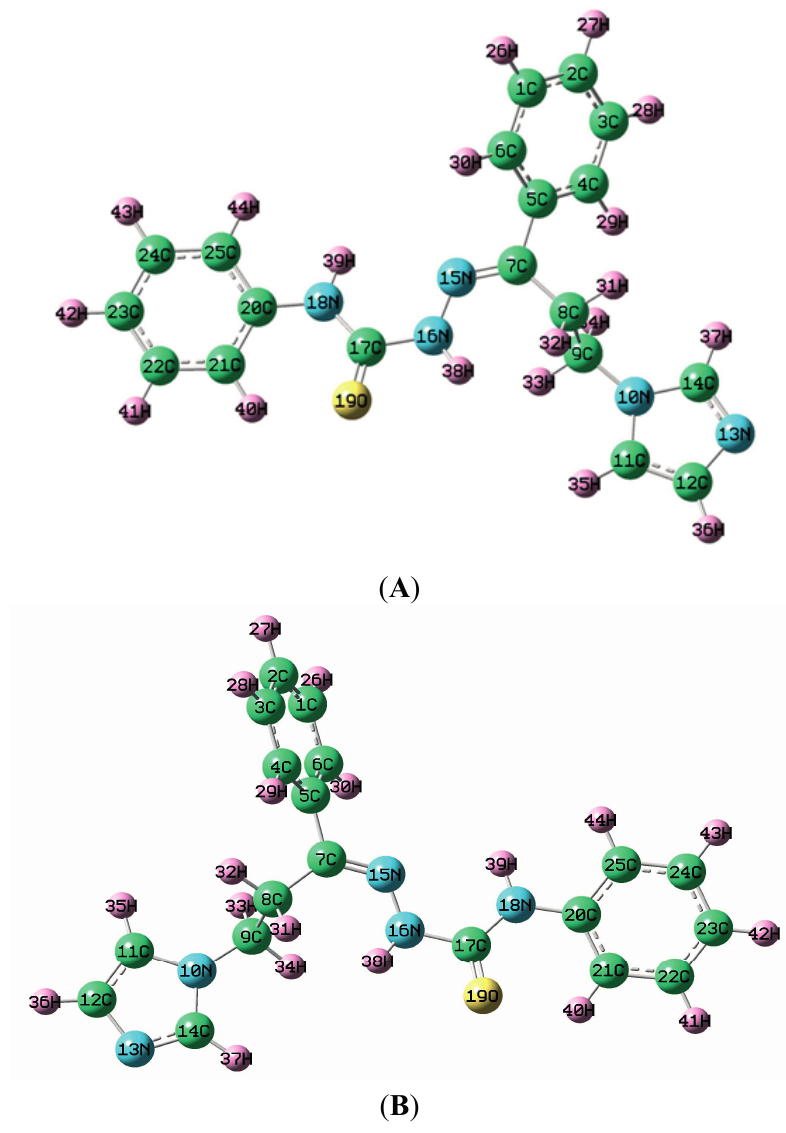
Figure 2. Rotational conformers of (2 E )-HIPC. ( A ) Conformer I by rotation of scan 1 = − 71.425° and scan 2 = 0° or 360°. Energy (B3LYP) = 1084.7055 hartree; ( B ) Conformer II by rotation of scan 1 = − 71.574° and scan 2 = 0° or 360°. Energy (B3LYP) = 1084.6857